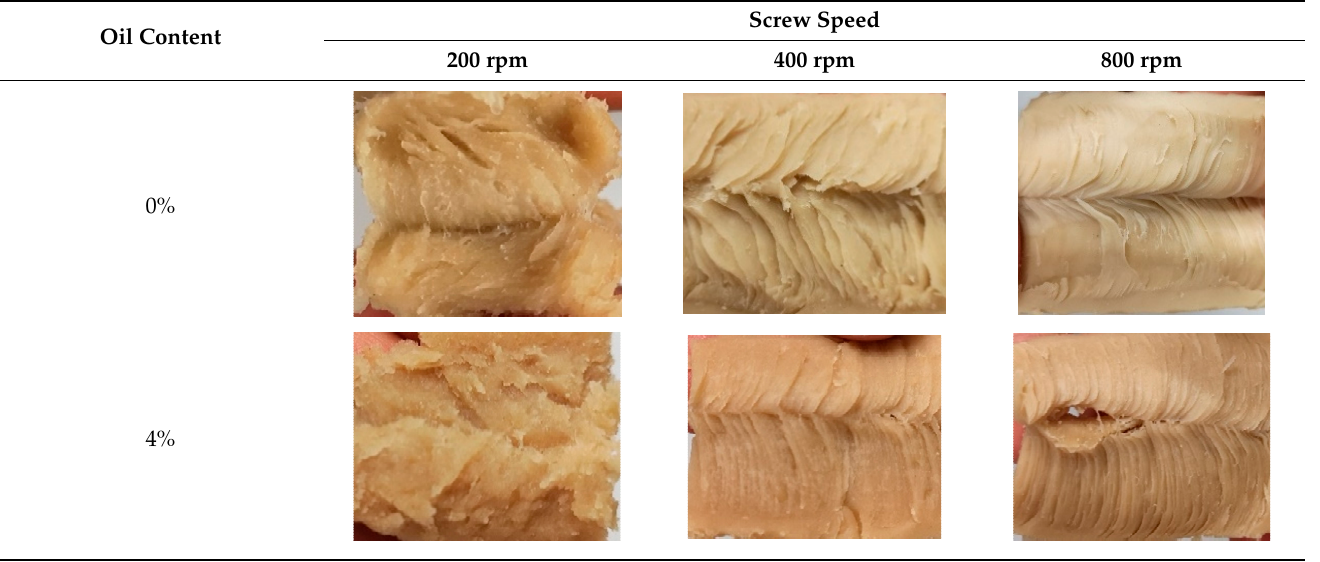
Table 3. Images of the extrudate samples teared immediately after extrusion processing. Effect of screw speed on the anisotropic structure of samples with 0 and 4% oil. Oil was added at position 2, barrel temperature was 140 °C, total mass flow was 10 kg/h and water content was 51–53% for all samples.